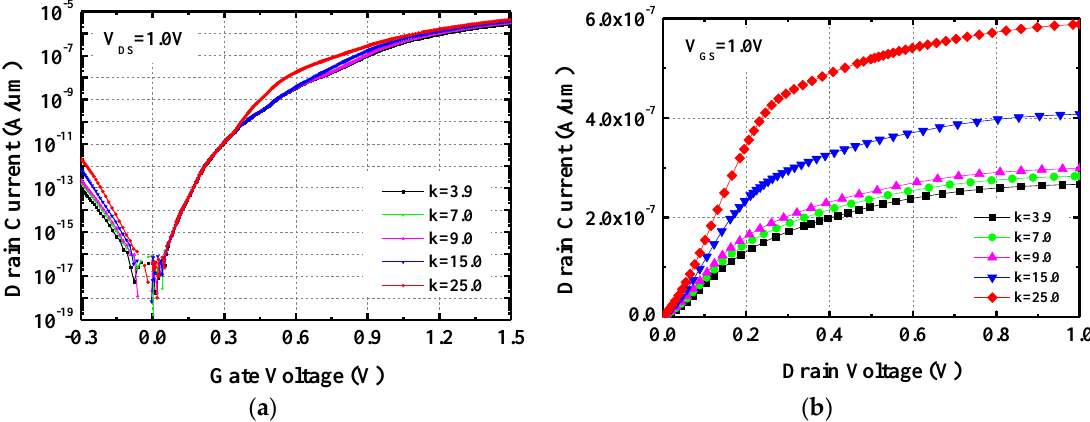
Figure 2. ( a ) Transfer characteristics at V DS = 1.0 V ( b ) output characteristics at V GS = 1.0 V with different κ values of spacers.